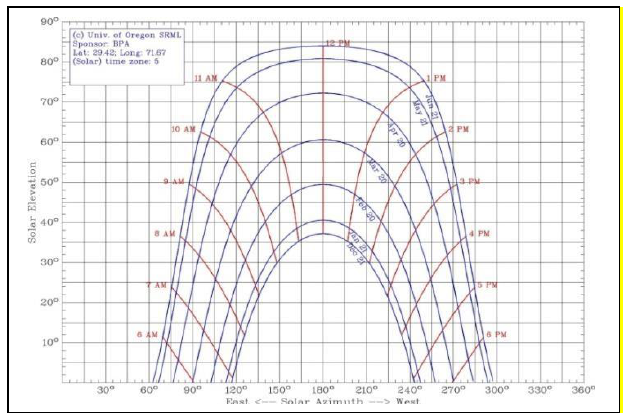
Fig. 14. Sun chart of site location (Bahawalpur)